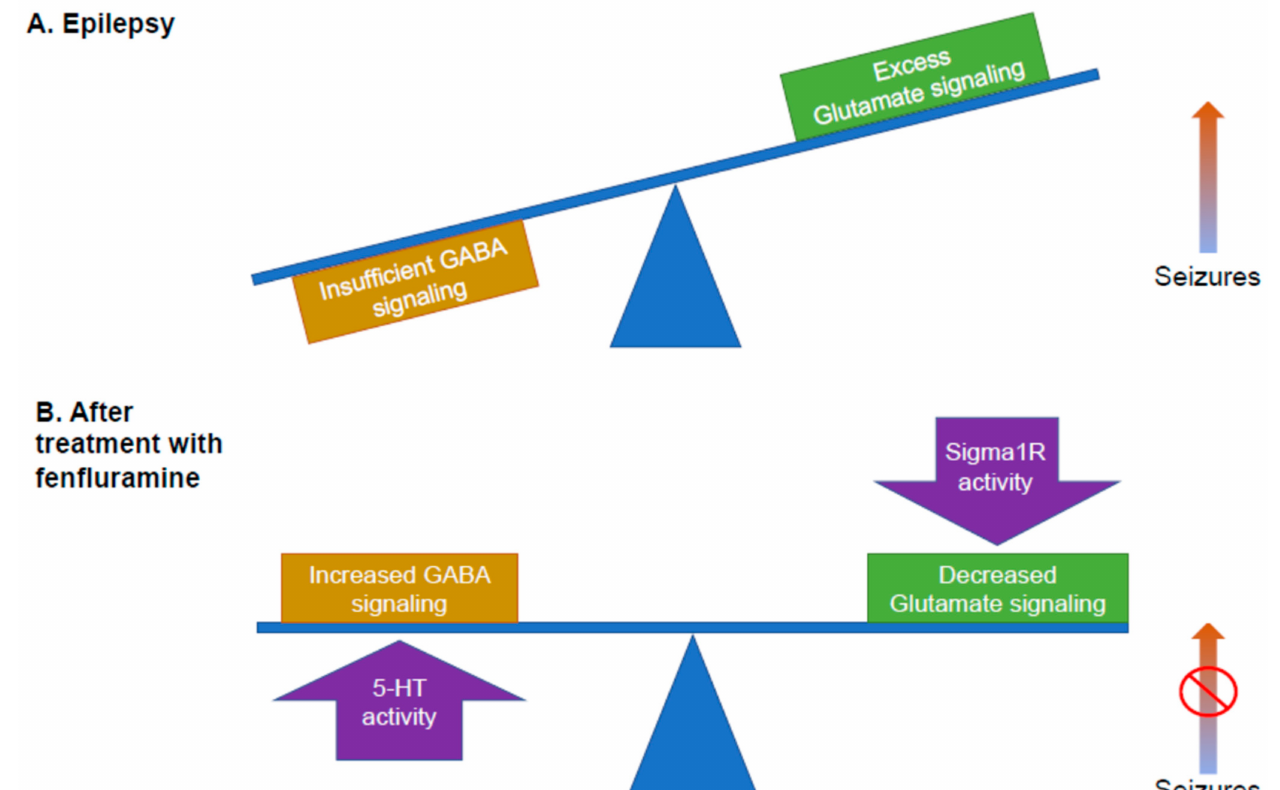
Figure 1. Potential mechanism of fenfluramine. Epilepsy is thought to generate an imbalance between inhibitory GABA signaling and excitatory glutamatergic signaling, leading to seizures. In the above figures, the balance between inhibitory and excitatory signaling is indicated by the blue balance beam. ( A ) Too much glutamate signaling results in seizures (e.g., the right arm of the balance beam moves upward). ( B ) Balance between inhibition and excitation is restored by the dual activities of fenfluramine: the activity of fenfluramine at 5-HT receptors results in increased GABA signaling, boosting inhibition, while the activity of fenfluramine at the Sigma1R reduces glutamatergic signaling, decreasing excitation. This mechanism is consistent with much, but not all, of the published research and is presented as a working model. 5-HT, serotonin; GABA, gamma aminobutyric acid; Sigma1R, Sigma1